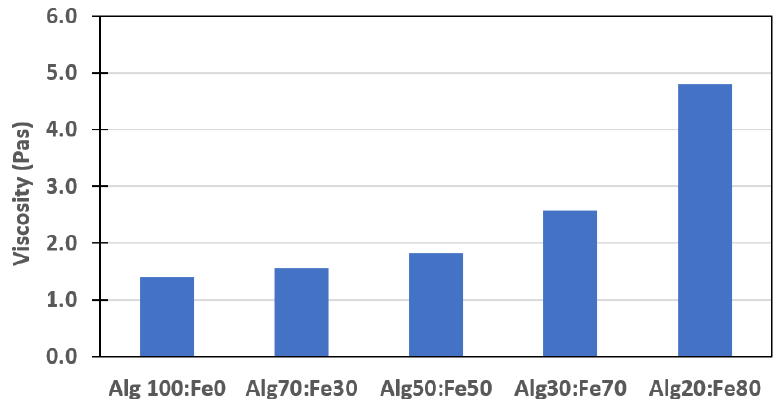
Figure 7. Alginate solution containing varying iron (Fe) powder content